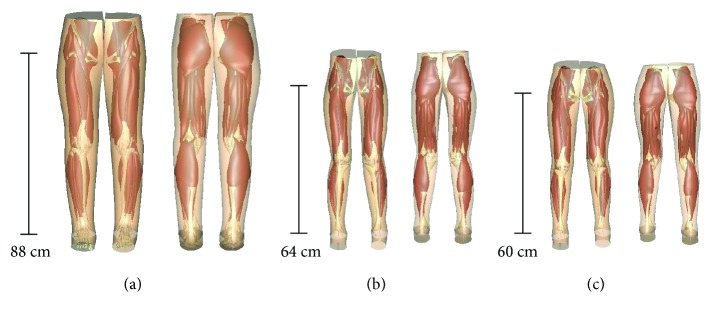
(a) The generic lower limb model based on the anatomy of an adult female (Oberhofer et al. 2009). (b) A fitted lower limb model of a child without CP. (c) A fitted lower limb model of a child with CP. Leg lengths of each model, ranging from the hip joint center to the ankle joint center, are given as reference.